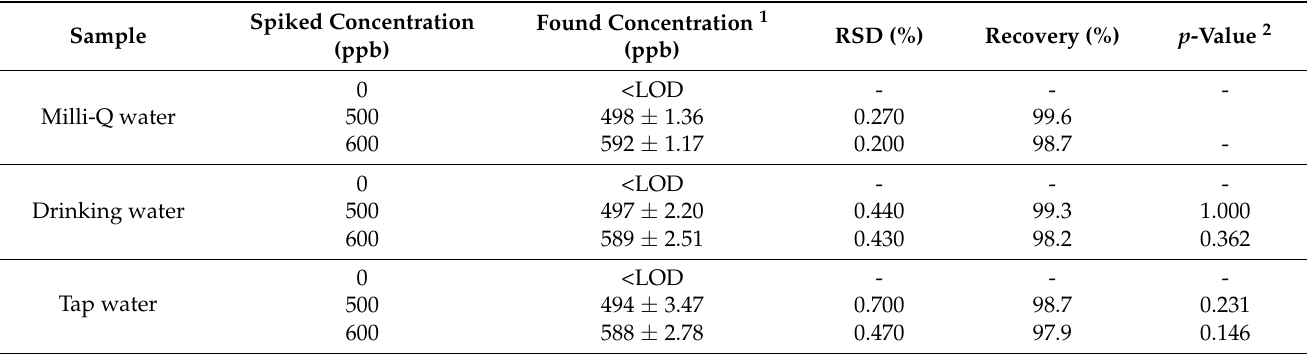
Table 4. Recovery rate of cadmium(II) ion in spiked water